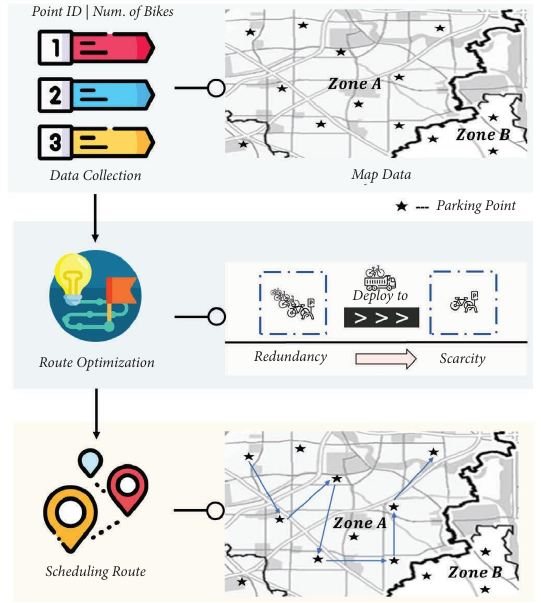
Figure 1: Te schema of existing scheduling (map data (part of Beijing):